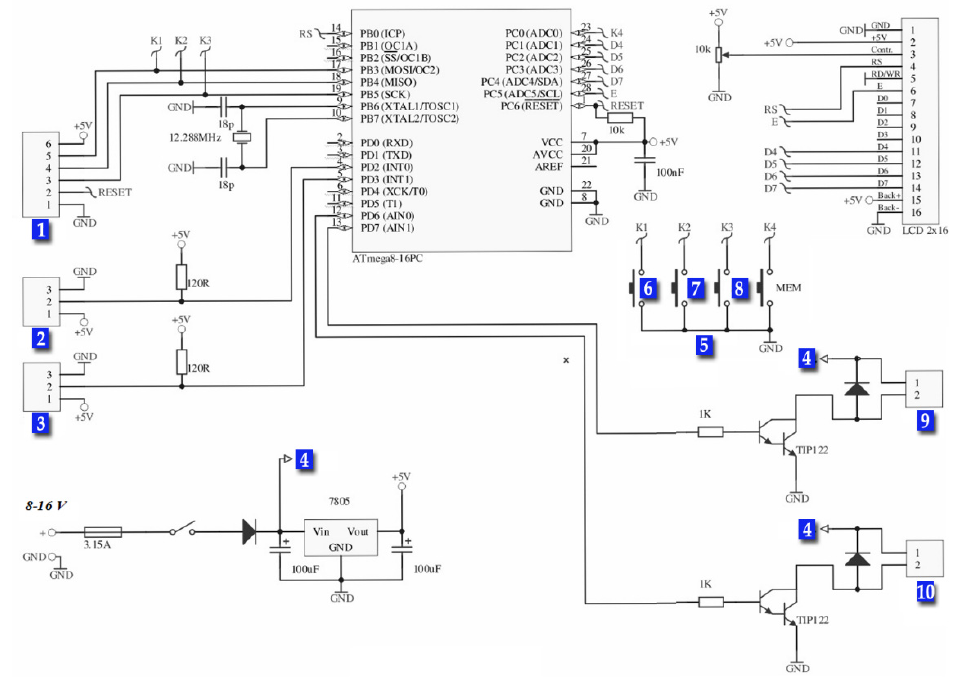
Figure 2. A diagram of the controller used in the test facility (PL 223195): 1—Programmer, 2—Sensor 1, 3—Sensor 2, 4—Valves, 5—Terminal keyboard, 6—Up, 7—Down, 8—Further, 9—Valve 2, 10—Valve 1, Valve 2.